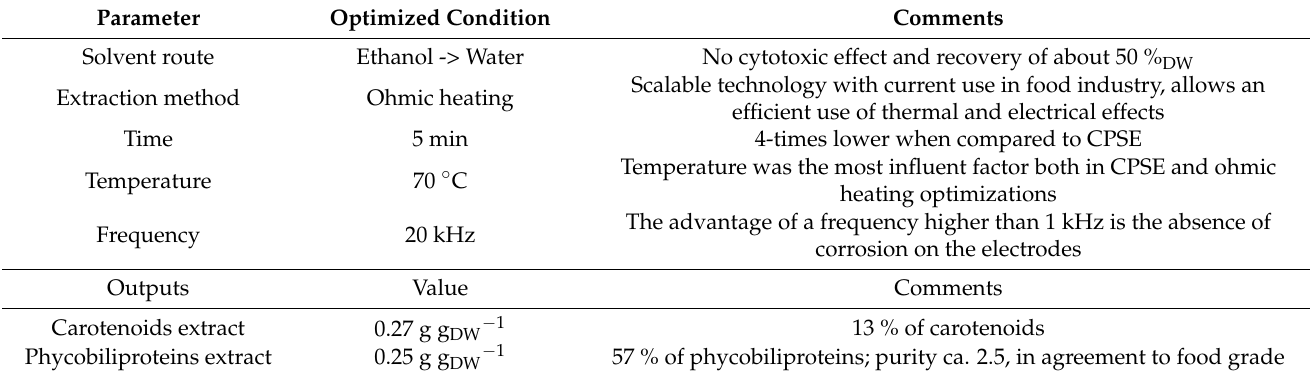
Table 2. Optimized parameters for Cyanobium sp. pigments extraction and final extract output